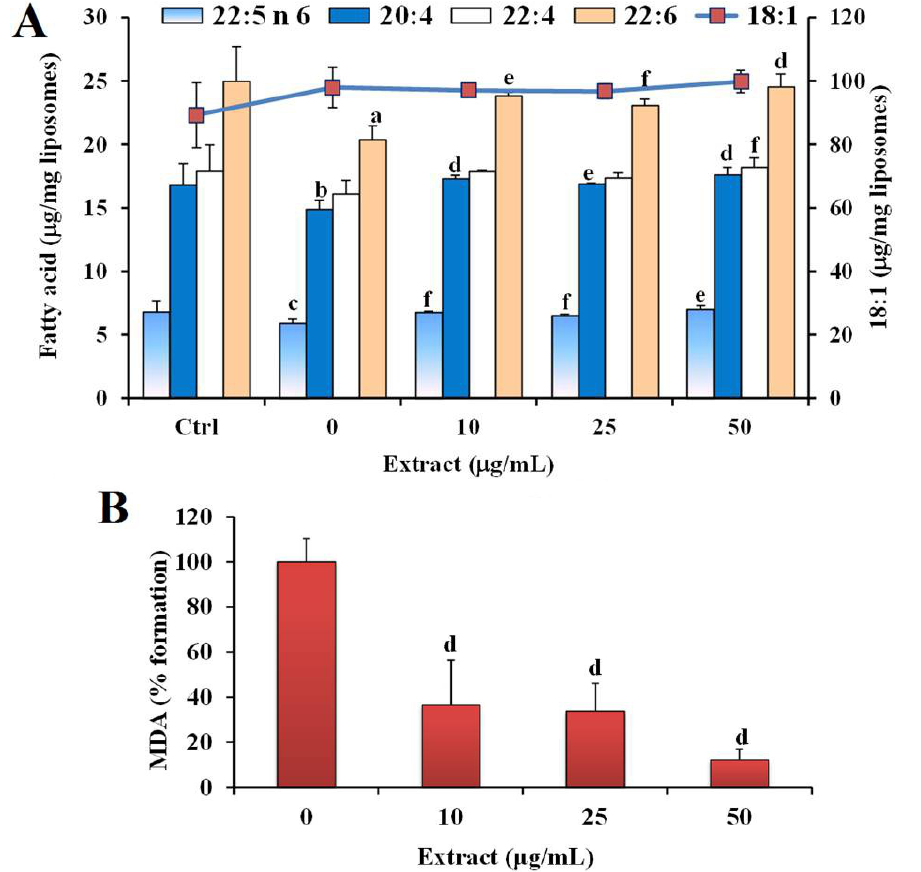
Figure 3. Values of the main unsaturated fatty acids (18:1, 20:4 n -6, 22:4 n -6, 22:5 n -6, and 22:6 n -3) expressed as μg/mg liposomes ( A ) and malondialdehyde (MDA) expressed as % of formation ( B ) measured in the control (Ctrl) and during liposome oxidation at 37 °C for 24 h with 5 μM CuSO in the absence (oxidized control, 0) and in the presence of different 4 amounts (10, 25, 50 μg/mL) of methanolic extract of C. coccineum . a = P < 0.001, b = P < 0.01, c = P < 0.05, versus Ctrl; d = P < 0.001, e = P < 0.01, f = P < 0.05 versus oxidized control; ( n =